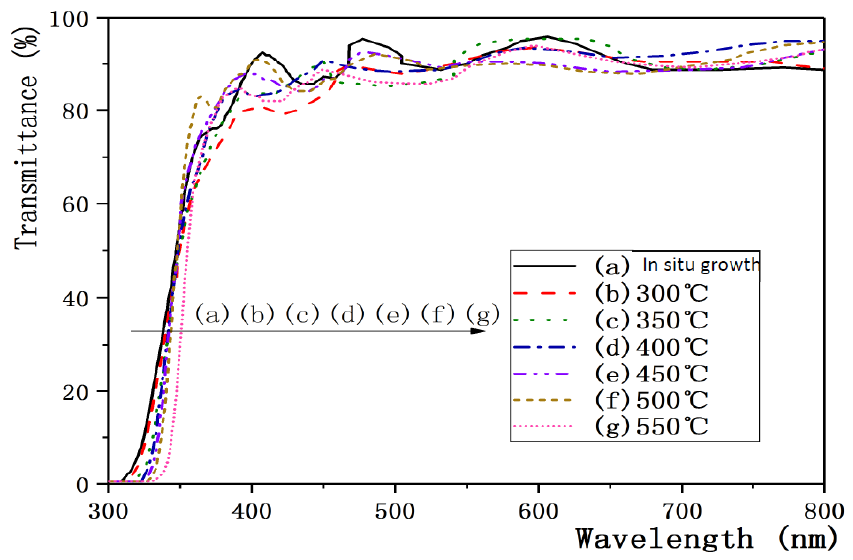
Figure 11. Transmission spectra of ZnO:Ga films prepared at different annealing temperatures [75]. Table 6. The performances of ZnO:Ga films produced at different annealing temperatures [75]. Annealing Temperature ( ◦